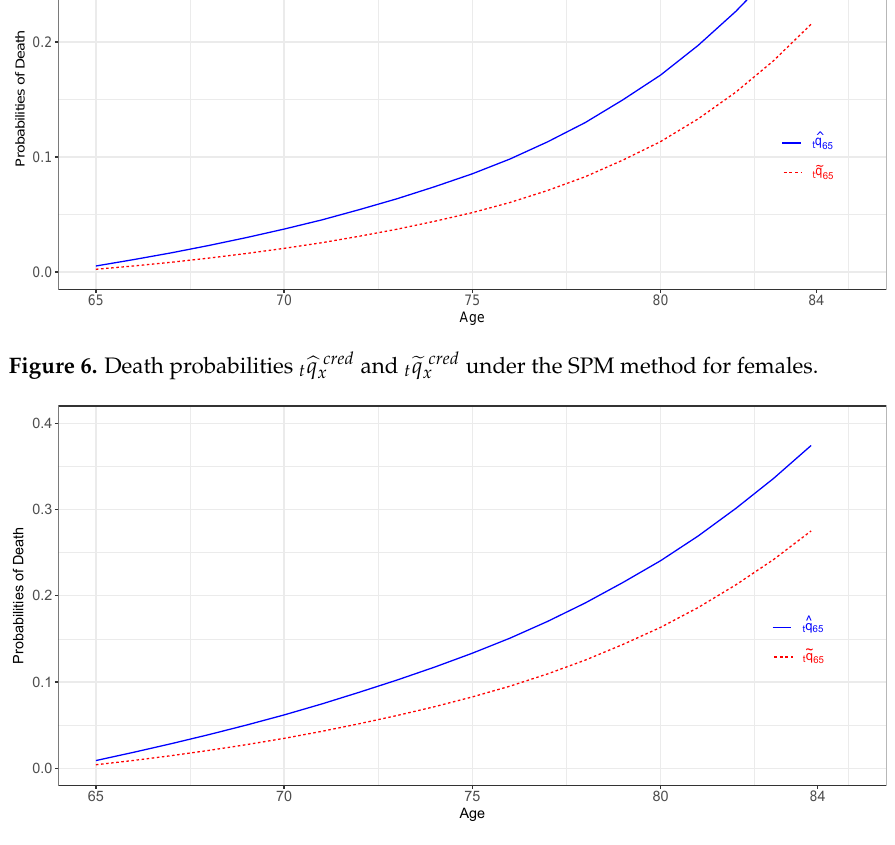
Figure 7. Death probabilities t (cid:98) q cred x and t (cid:101) q cred x under the SPM method for the total